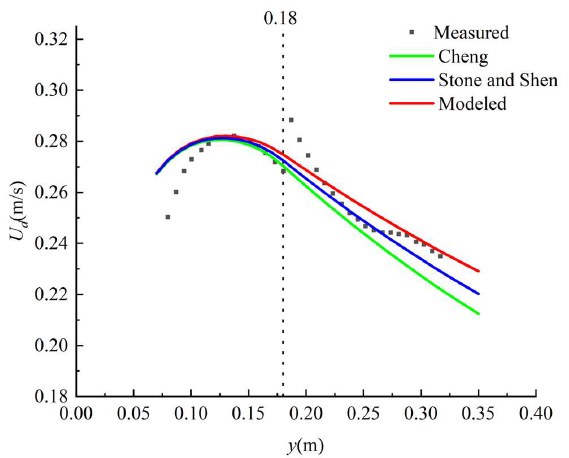
Figure 2. Water depth-averaged streamwise velocity between the experimental data and analytical solution in case 1. The green line occurs when ϕ 1 = 0.8279 (from Cheng [26]). The blue line occurs when φ 2 = 0.6914 (from Stone and Shen [25]). The red line occurs when φ 3 = 0.4845 (from the presented model ( ϕ = U v / U d )). The dotted line indicates the boundary between the non-vegetated and vegetated areas.